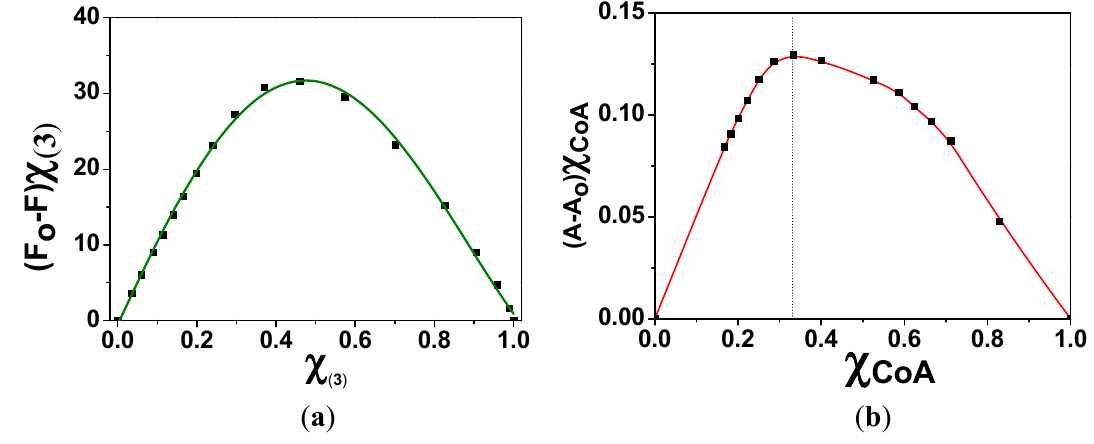
Figure 5. Job’s plots corresponding to the following interaction studies: ( a ) ( 3 ) with Hg(II), obtained from fluorescence spectroscopy (591 nm) data corresponding to the titration curve of ( 3 ) with mercury cations in DMSO/water (90/10, v/v) at pH = 9.7 (TRIS); and ( b ) CoA with Hg(II), from UV/Vis spectroscopy (300 nm) data corresponding to the titration of CoA with mercury cations in DMSO/water (90/10, v/v) at pH = 7.4